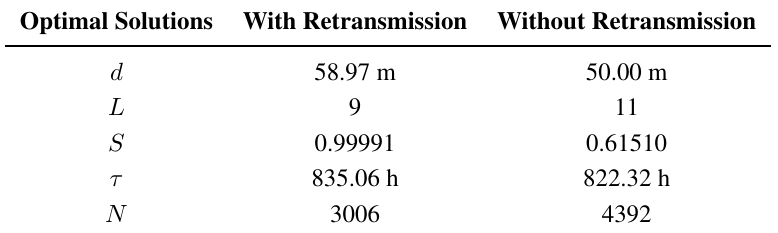
Table 4. Optimization results of non-uniform deployment. The details of the symbols can be seen in the